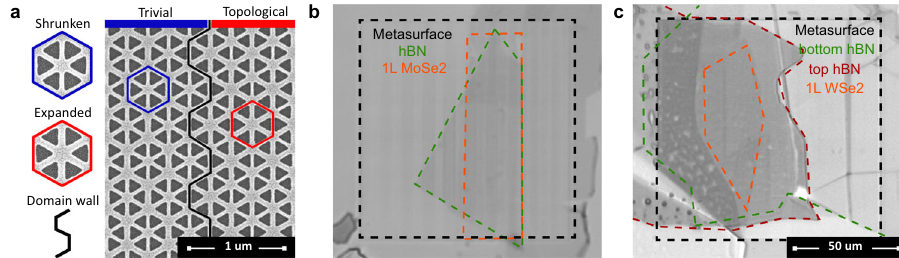
Fig. 2 Experimental samples of topological polaritonic metasurfaces. a SEM images of topological photonic metasurface with unit cells of trivial and topological domains indicated by hexagons and the domain wall shown by the armchair shaped black line. Optical microscope images of the two topological polaritonic metasurface samples (black) with TMD monolayers (orange) and hexagonal boron nitride (hBN) spacers (green, crimson). b MoSe 2 monolayer transferred directly onto the metasurface and covered with a 12 nm hBN fl ake. c WSe2 monolayer incapsulated by 10 nm (bottom) and 30 nm (top) hBN fl akes on top of another metasurface.